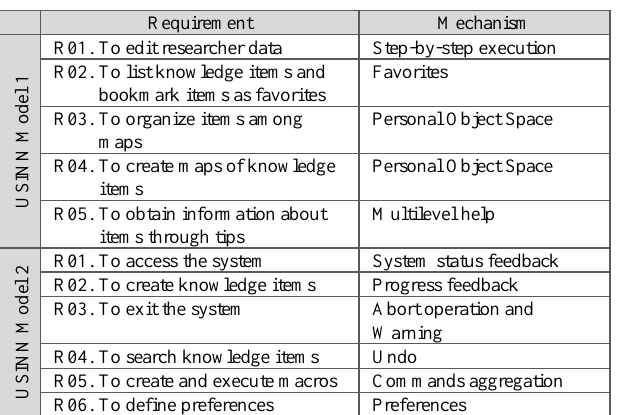
TABLE III. F UNCTIONAL REQUIREMENTS AND USABILITY MECHANISMS DESCRIBED IN THE MODELS FOR PROTOTYPING TASKS